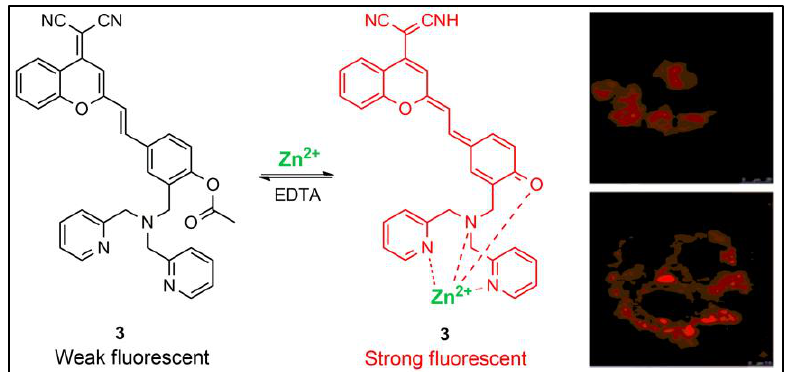
Figure 4. Fluorescence recognition mechanism and reversibility of probe 3 with Zn 2+ ion. Fluorescence image of MCF-7 cells pretreated with probe (10 μ M) for 30 min (upper panel) and after incubated with Zn 2+ (100 μ M) for 1 h (lower panel). Adapted with permission from [46]. Copyright (2020) Elsevier.